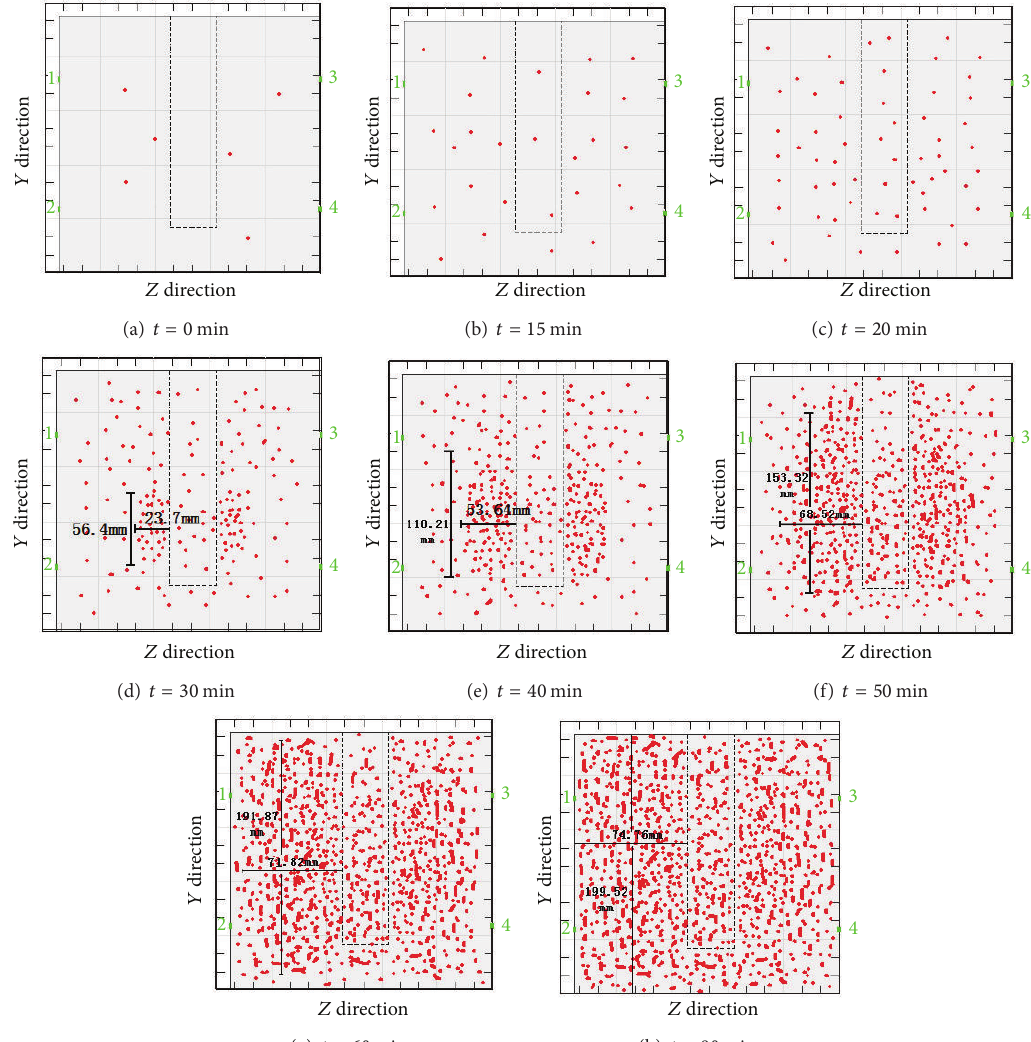
Figure 5: The expansion status of the first occurring cracks A and